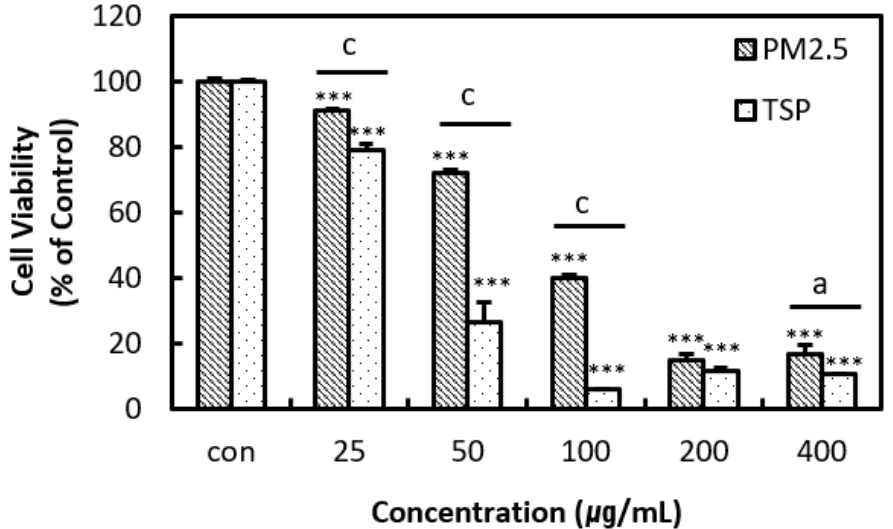
Figure 4. Cell viability measured by the water-soluble tetrazolium assay. Human lung epithelial cells (A549) were treated with PM2.5 and TSP at final concentrations of 0, 25, 50, 100, 200, and 400 µ g/mL for 24 h. Experiments were repeated thrice. The values are reported as the mean ± SD (Student’s t -test, *** p < 0.001, vs. control; a p < 0.05, c p < 0.001).